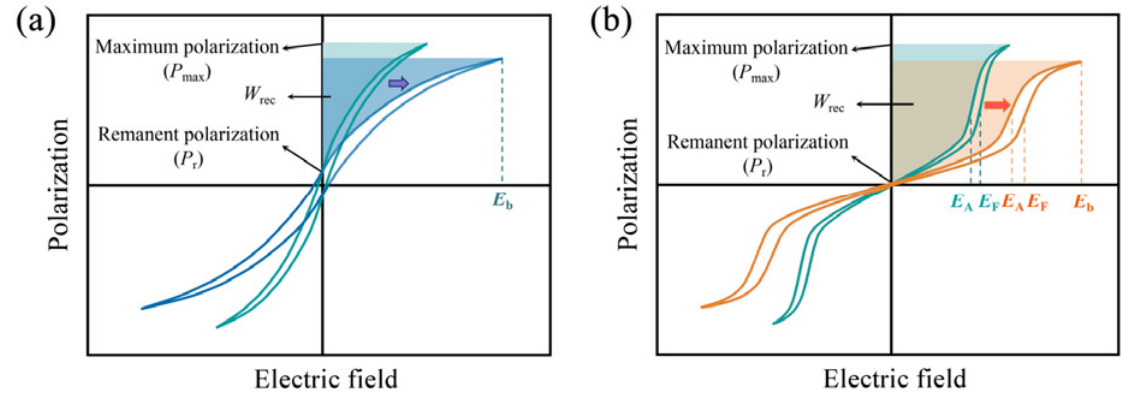
Fig. 1 A schematic diagram of P – E loops optimized for (a) ferroelectrics (FEs) and (b) antiferroelectrics (AFEs) by adjusting the electric breakdown strength. Different from the FEs, AFEs have the AFE–FE and FE–AFE phase transitions, which offers the potential to compensate for the decrease in W rec caused by sacrificial